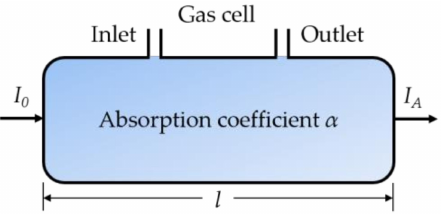
Figure 1. Principle of absorption spectroscopy